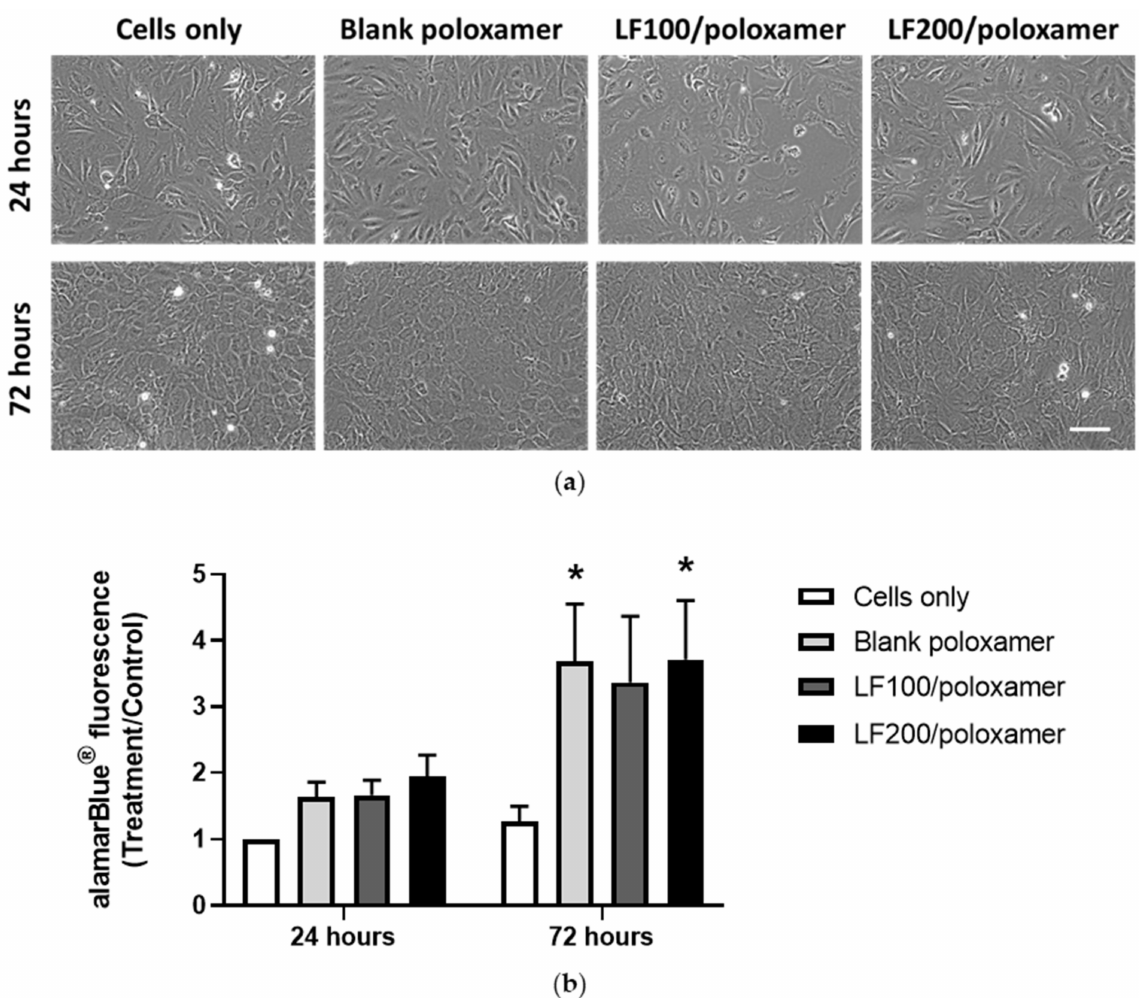
Figure 3. Poloxamers increase primary rat osteoblast viability at 72 h in the presence or absence of LF. ( a ) Representative phase images of osteoblasts. Scale bar = 200 µ m. ( b ) Osteoblast viability results at 24 and 72 h. Results from three biological experiments were pooled together ( n = 3 for each experiment). The cells-only group had inserts hanging on the well without any gel added in the inserts. The 200- µ L poloxamers gel was added to each insert. Data shown are the mean ± SEM; two-way ANOVA with post hoc Dunnett’s test, * p < 0.05 versus the cells-only group (control) at that time